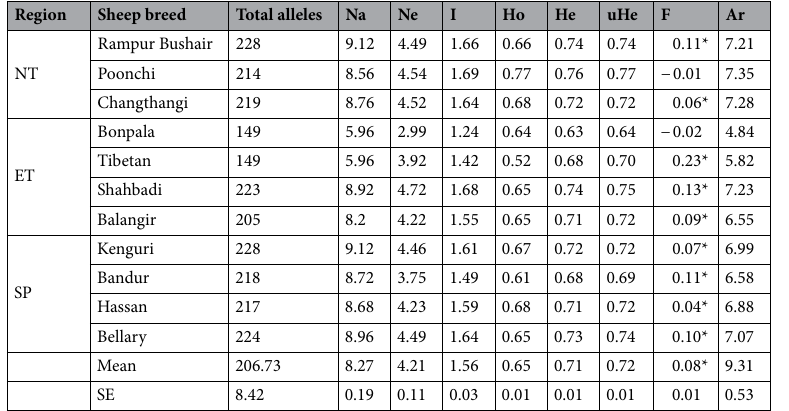
Table 4. Genetic diversity indices of 25 microsatellite markers in 11 populations of sheep in India (See Fig. 1 for the location of each population). Na = Number of alleles; Ne = Number of effective alleles; I = Shannon’s information index; Ho = Observed heterozygosity; He = Expected heterozygosity; uHe = Unbiased expected heterozygosity; F = Heterozygote deficiency (inbreeding coefficient); Ar = Allelic richness. * P < 0.05.